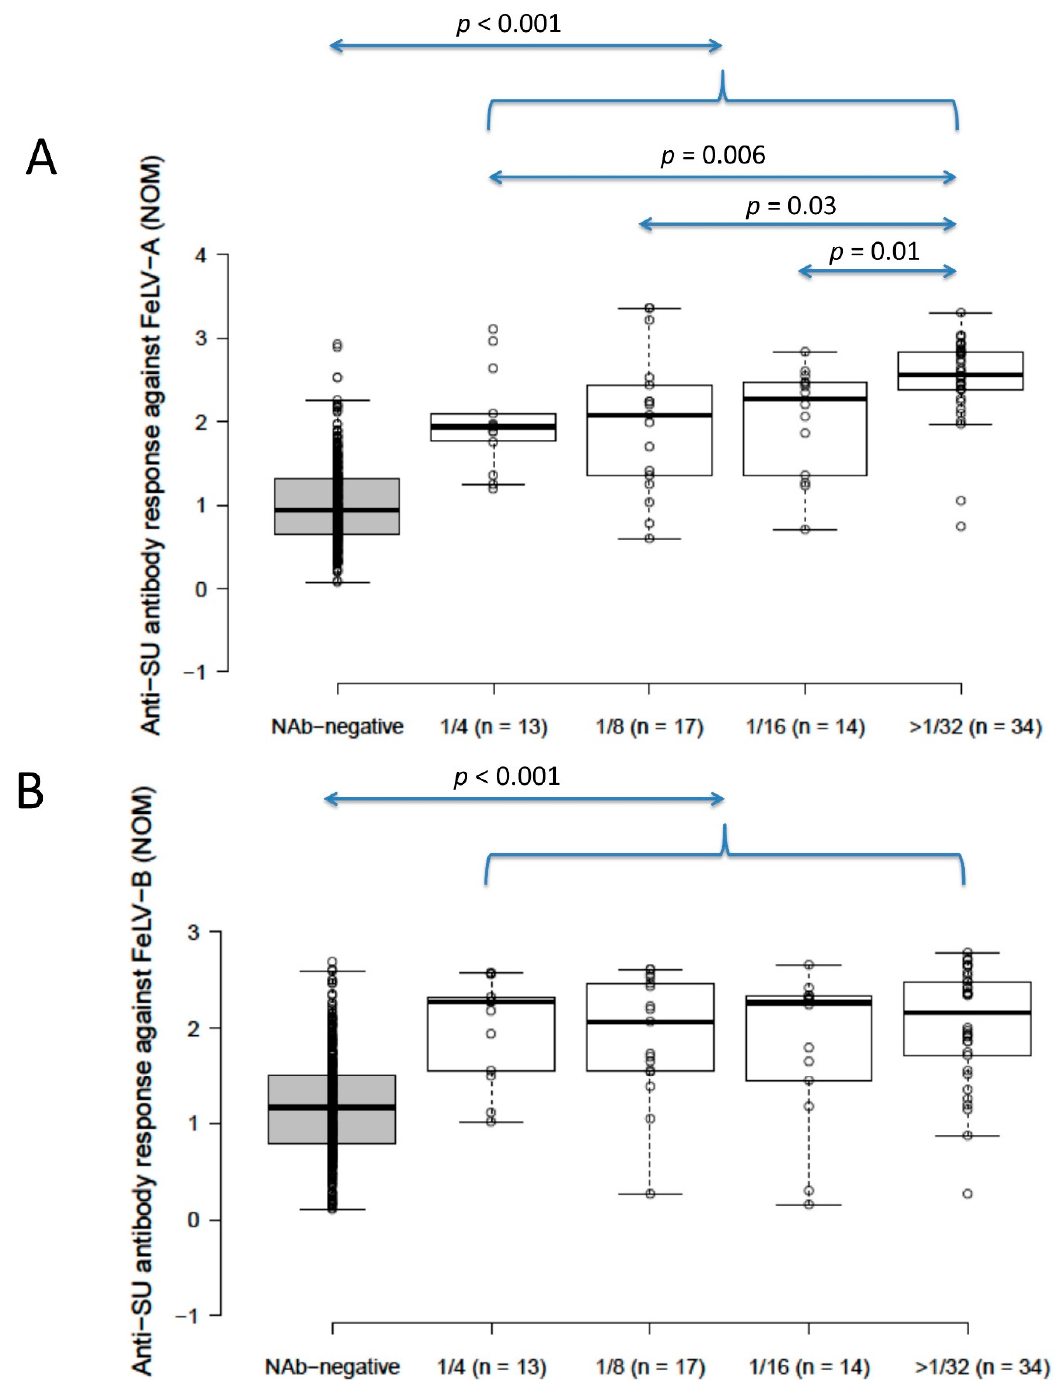
Figure 2. Results from anti-SU antibody ELISA testing according to NAb titre (( A ) anti-FeLV-A SU antibody ELISA results, ( B ) anti-FeLV-B SU antibody ELISA results). Anti-SU antibody levels against FeLV-A for strongly neutralising samples ( ≥ 32) were significantly higher than other NAb-positive samples (i.e., 4, 8 and 16) ( p = 0.03; REML testing), but anti-SU antibody levels against FeLV-B were not significantly different between NAb-positive groups ( p = 0.32; REML testing). All NAb-positive groups had significantly higher median anti-SU antibody levels against both FeLV-A and FeLV-B SU than NAb-negative samples ( p < 0.001; least significant difference testing). Data points are plotted as open circles, centre lines show the medians, box limits indicate the 25th and 75th percentiles, and whiskers extend 1.5 times the interquartile range from the 25th and 75th percentiles. NOD = normalised optical density, NAb = neutralising antibody, SU = surface unit. The positive control sample included on each plate had a mean absorbance of 2.6 and the negative control had a mean OD of 0.5.